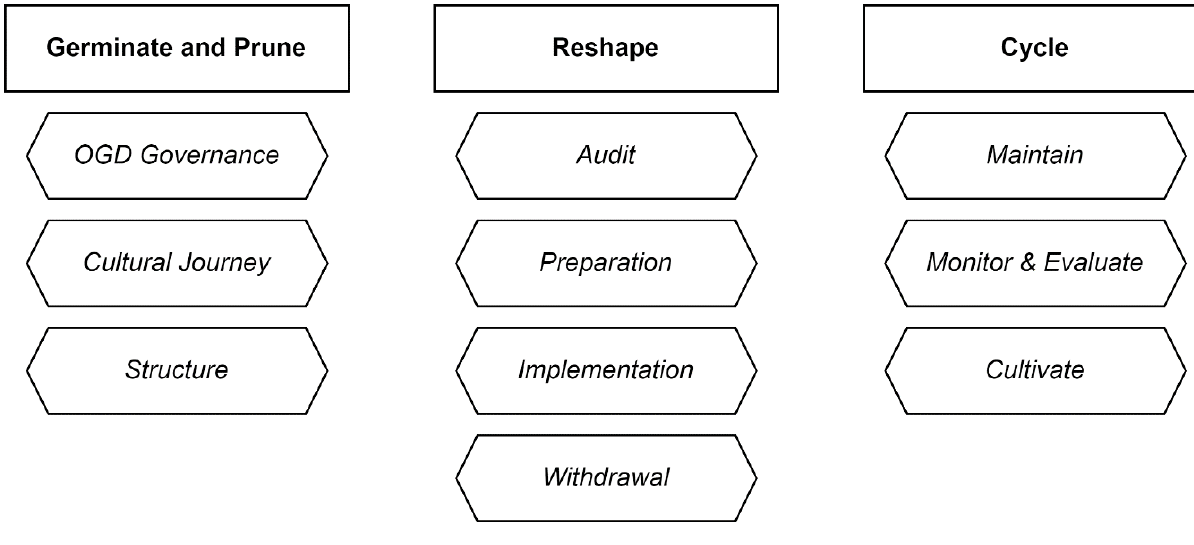
Figure 3: Overview of the fields of work